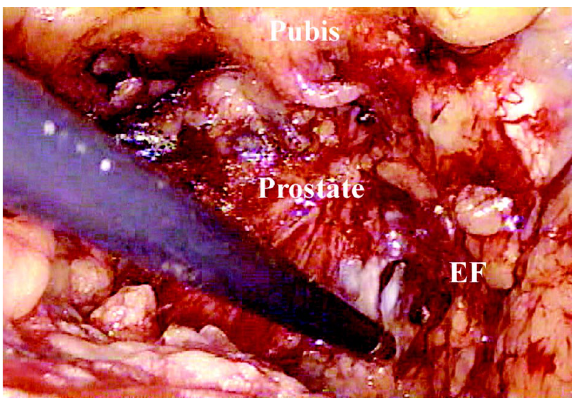
Figure 2 – Opening of endopelvic fascia (EF). The assistant pulls the prostate to the contralateral side and the surgeon sec- tions the endopelvic fascia with